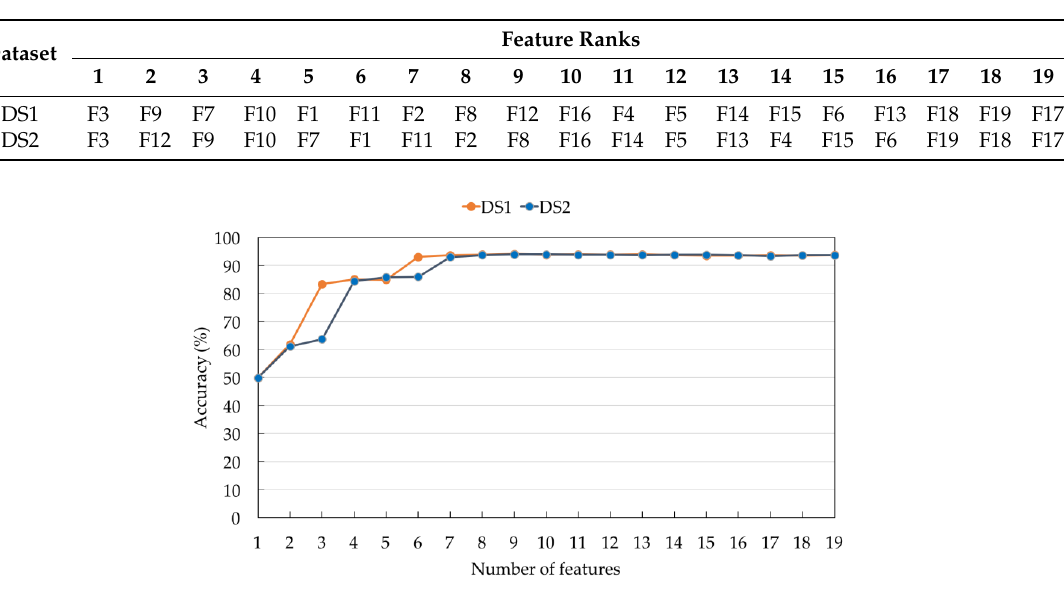
Figure 9. Comparison of average accuracy using feature ranking obtained from DS1 and DS2.